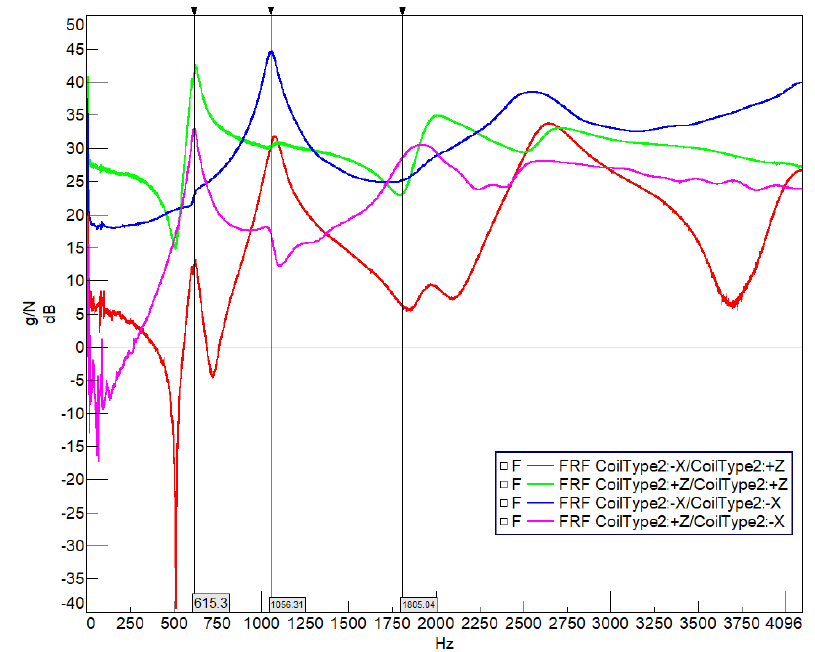
Figure 13. Drive point FRF for Coil Type-2.